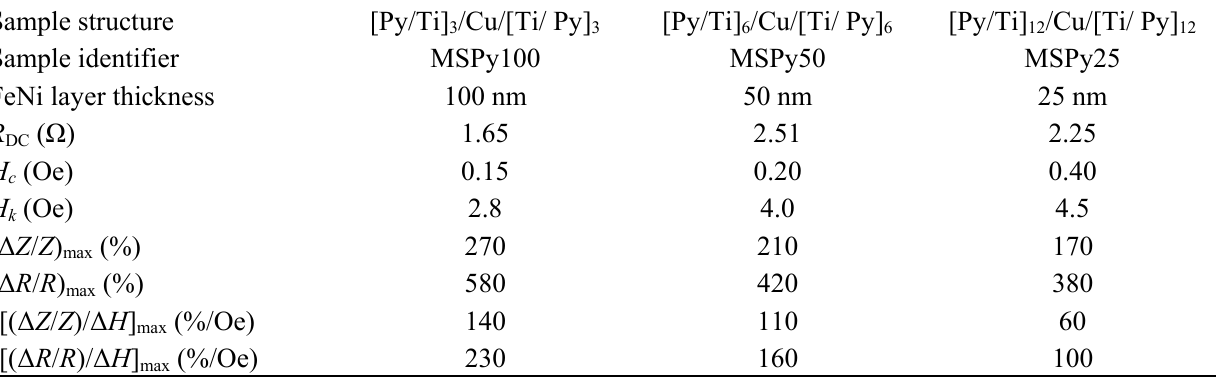
Table 1. Description of the samples and summary of selected